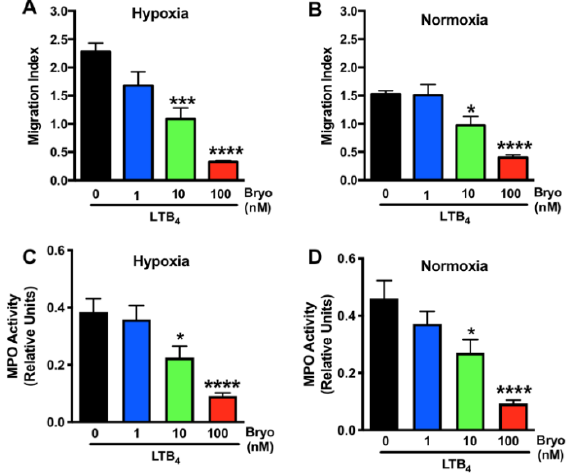
Figure 3. Dose-dependent effects of Bryostatin-1 in altering neutrophil activation and transmigration. Bryostatin-1 (Bryo) showed a dose-dependent (1, 10, 100 nM) effect on neutrophil activation as well as transmigration across confluent human umbilical vein endothelial cell (HUVEC) monolayers toward leukotriene B4 (LTB 4 , 10 − 6 M) under ( A , C ) hypoxic and ( B , D ) normoxic conditions. The migration index was calculated by dividing the number of calcein-AM labeled neutrophils that migrated to LTB 4 by the number of cells that migrated to the vehicle. Neutrophil activation was determined by measuring myeloperoxidase (MPO) activity. All results are representative of at least three independent experiments (n = 5–7). Graphs present mean ± SEM, data were analyzed with ANOVA with Bonferroni post-tests, and significance is indicated by the following symbols: * p < 0.05 versus vehicle control, *** p < 0.001 versus vehicle control, **** p < 0.0001 versus vehicle